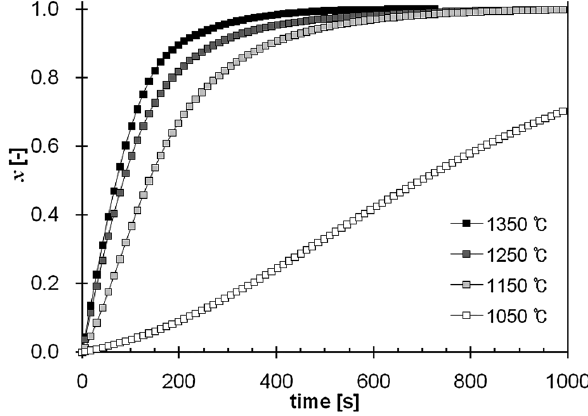
Fig. 4 Carbon conversion verses time curve, Kim et al.